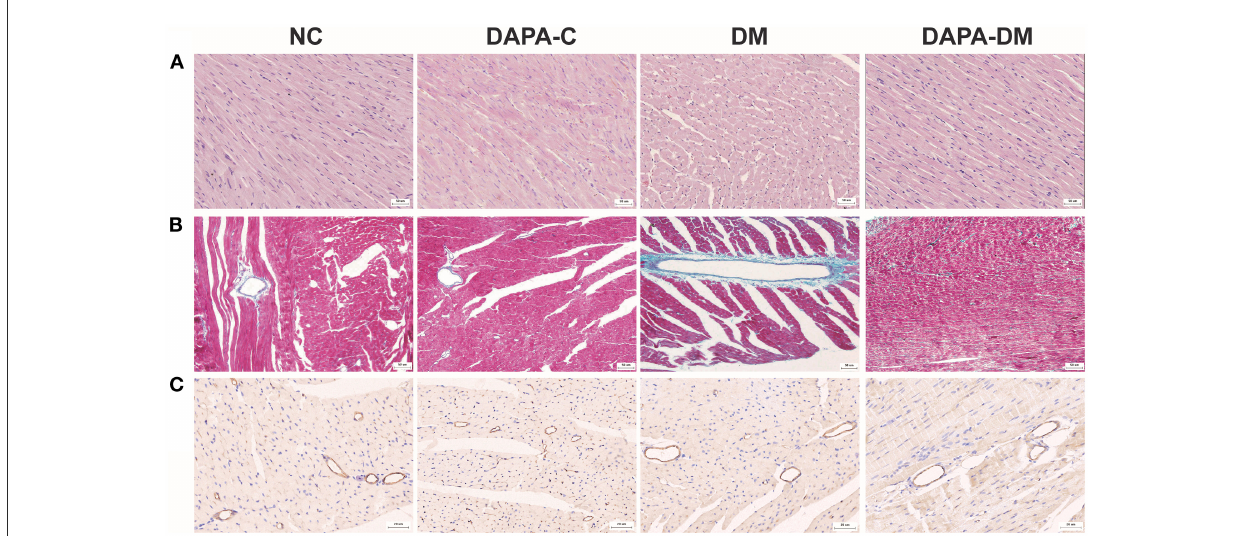
FIGURE5 Typical pathological images of the four groups at 8 weeks. (A) Representative H&E staining images of the four groups at 8 weeks. Magnification: × 200. (B) Representative Masson’s trichrome staining images of the four groups at 8 weeks. Magnification: × 200. (C) Representative CD31 staining images of the four groups at 8 weeks. Magnification: × 400. NC, normal control group; DAPA-C, DAPA-control group; DM, diabetic group; DAPA-DM, DAPA-diabetic group.